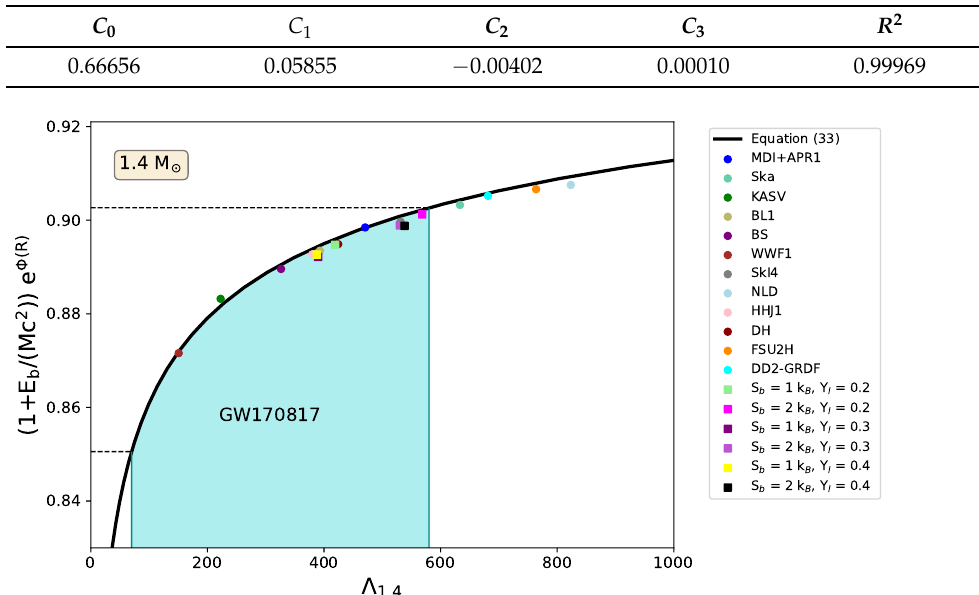
Figure 9. Universal relation connecting the dimensionless tidal deformability, the star’s binding energy and the compactness. The plot contains only the data for the 1.4 M (cid:12) configuration of each EOS. The circular and the rectangular points correspond to cold and isentropic EOSs, respectively. The solid line stands for the fit of Equation (33), which is performed for cold and hot EOSs. The shaded area shows the upper and lower values of the dimensionless tidal deformability ( Λ 1.4 = 190 + 390 − 1.4 M (cid:12) neutron star from analysis of GW170817 event